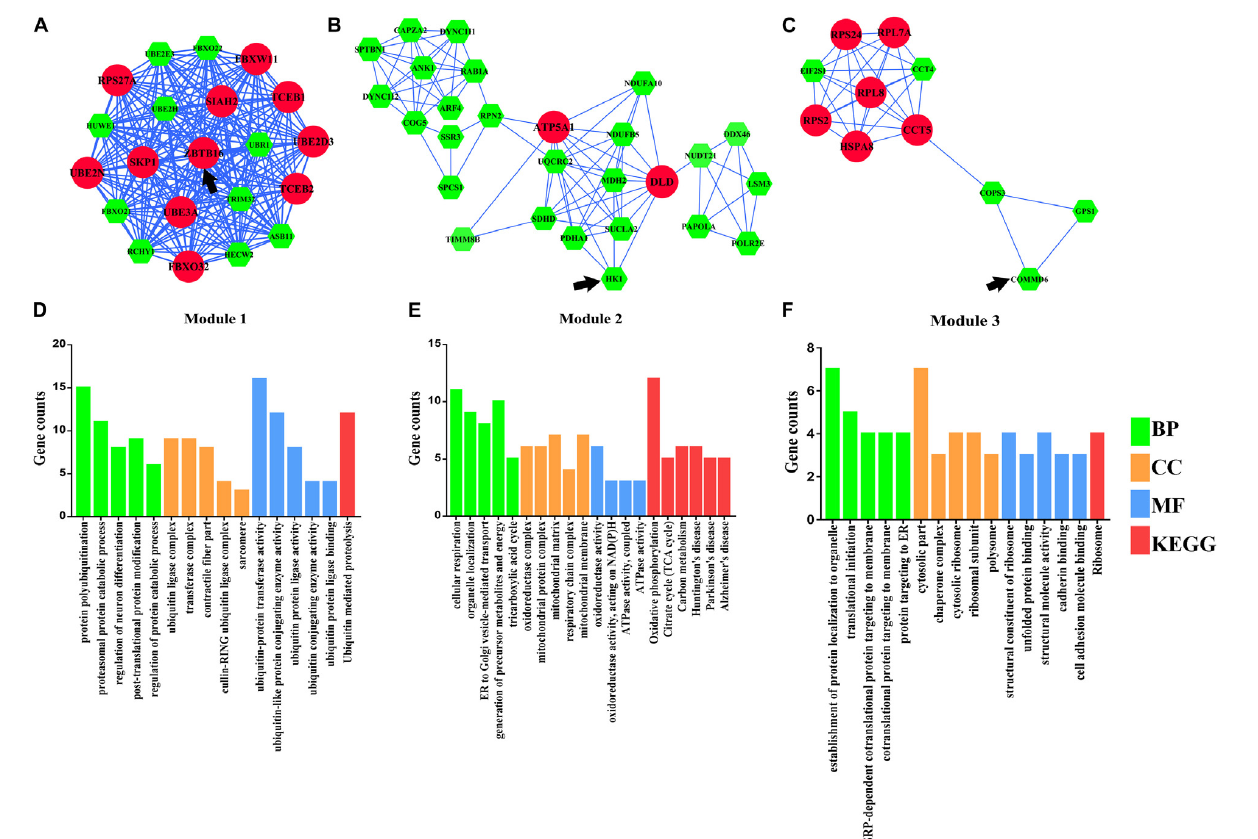
FIGURE 4 | Module analysis of differentially expressed genes (DEmRNAs). (A) Module 1. (B) Module 2. (C) Module 3. (D) Functional enrichment analyses of Module 1. (E) Functional enrichment analyses of Module 2. (F) Functional enrichment analyses of Module 3. Larger circles with red colors represent hub genes, smaller hexagons with green colors represent non-hub genes, and black arrows represent seed genes. BP, biological progress; CC, cellular component; GO, Gene Ontology; KEGG, Kyoto Encyclopedia of Genes and Genomes; MF, molecular function.